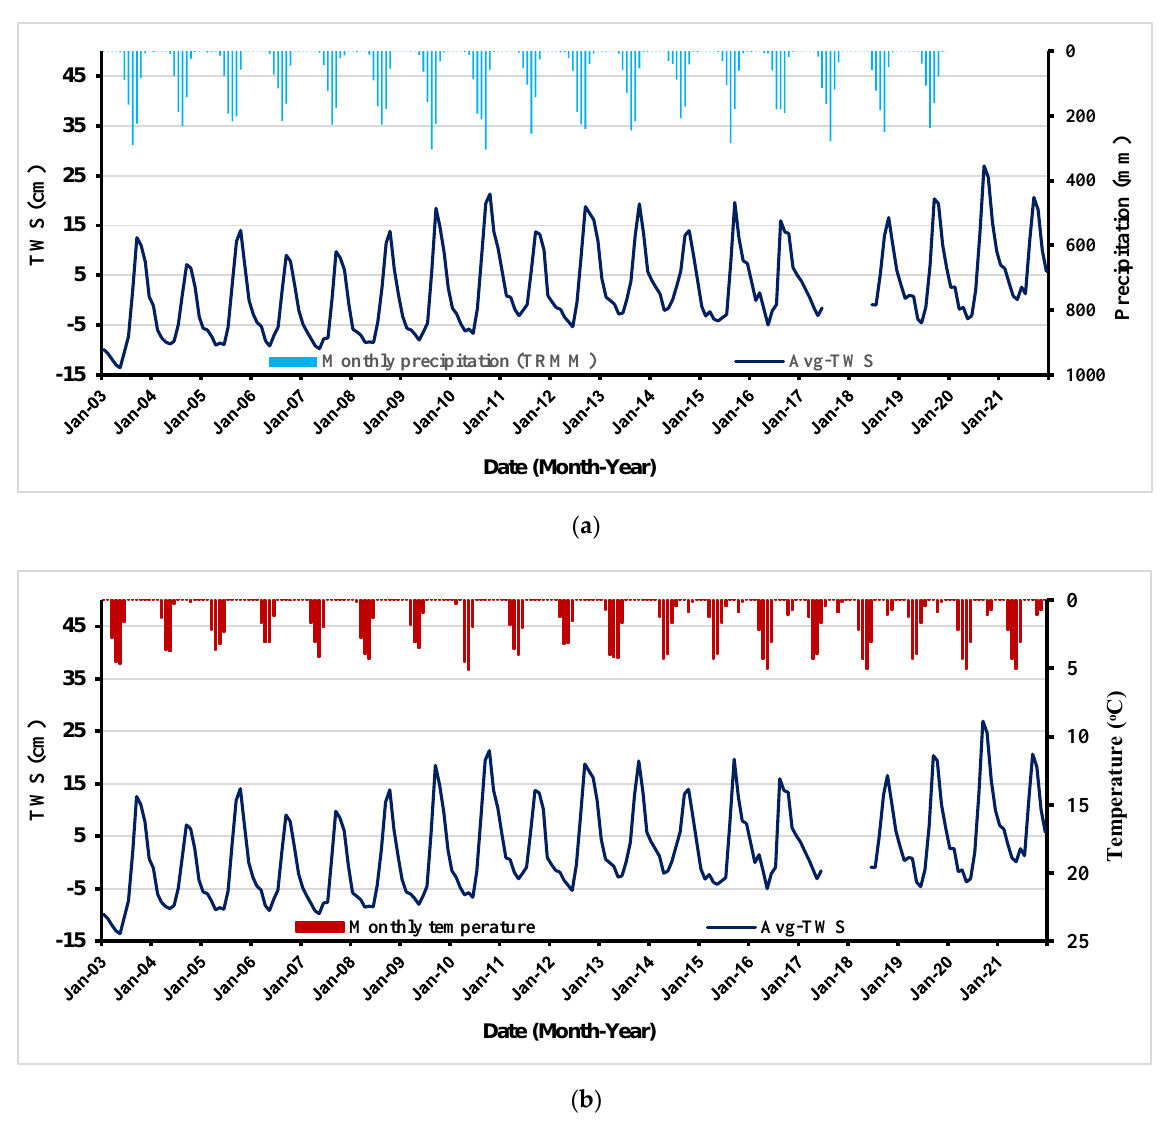
Figure 9. Evolution of precipitation and GRACE-derived Δ TWS anomaly ( a ), and Evolution of mean temperature anomaly and GRACE-derived Δ TWS anomaly ( b ) from 2003 to 2021 in Senegal.